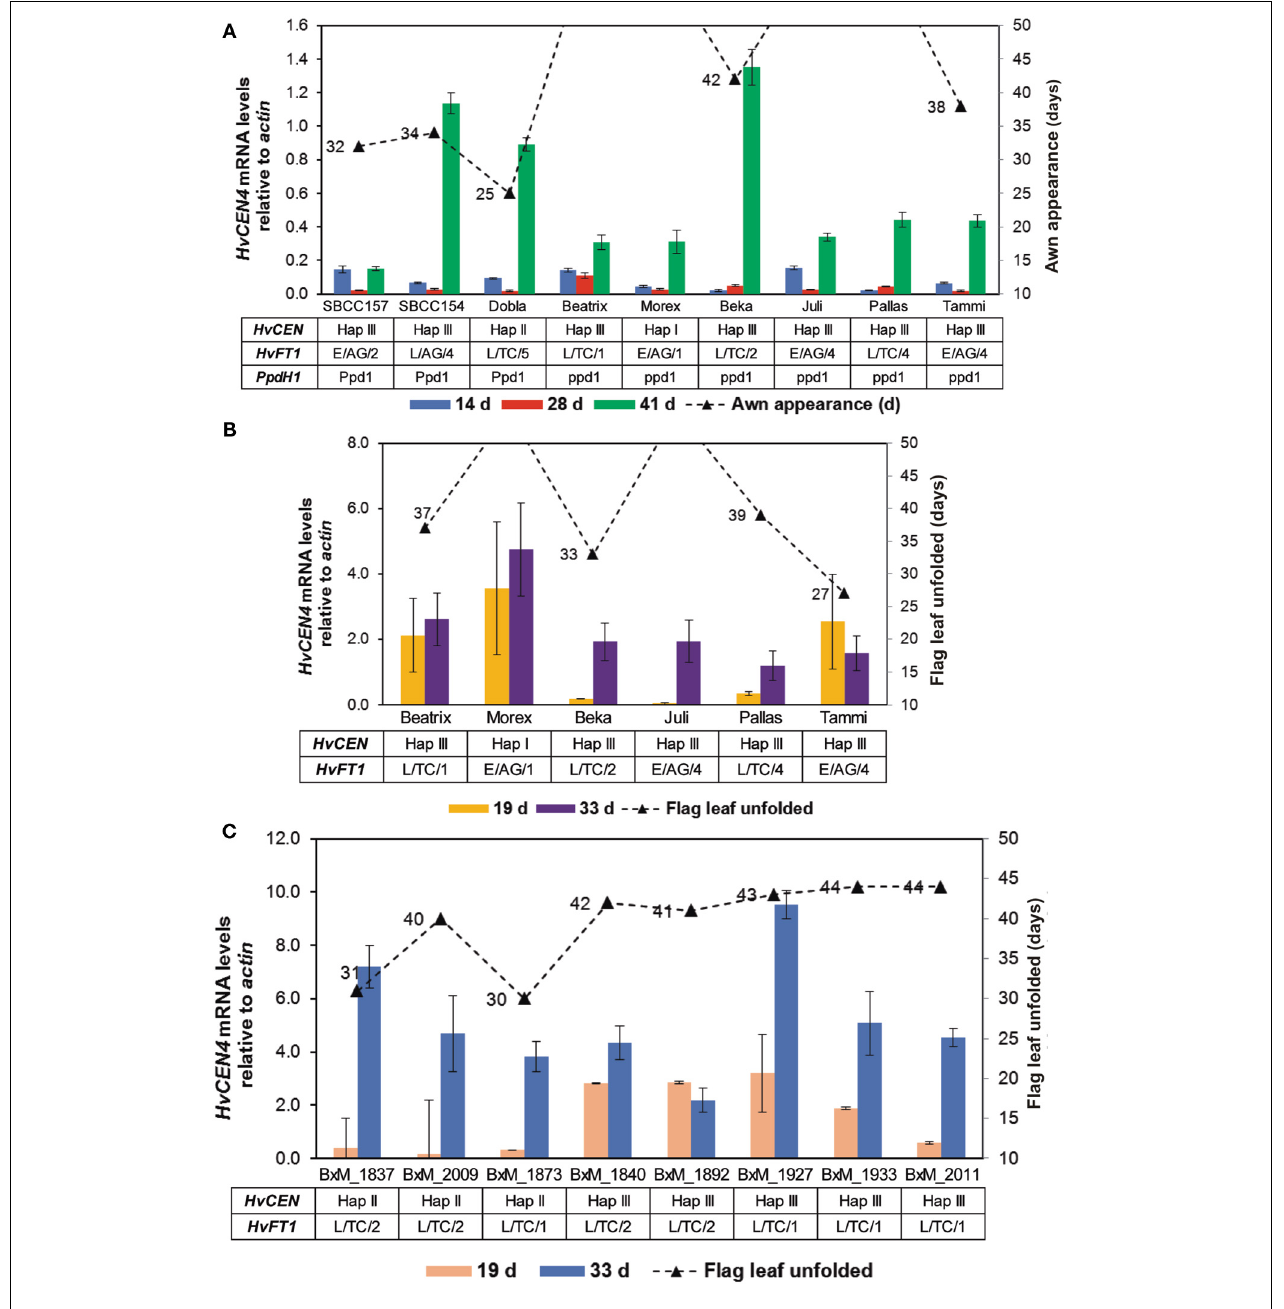
FIGURE 6 | HvCEN expression analysis by qPCR. HvCEN mRNA levels were quantified using the same conditions as for Figure 5 . (A) leaf tissue was harvested in the middle of the light period (after 8h light) 14, 28, or 41